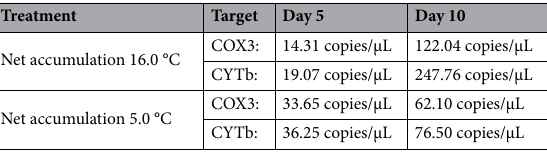
Table 1. Average Somatochlora hineana eDNA concentrations—accumulation experiment.